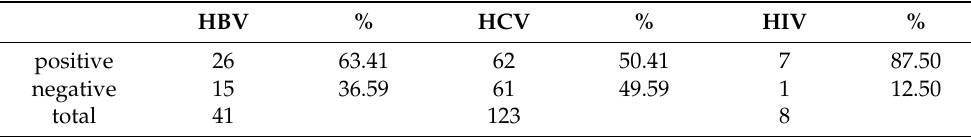
Table 2. Patient declaration rate for infectious diseases.